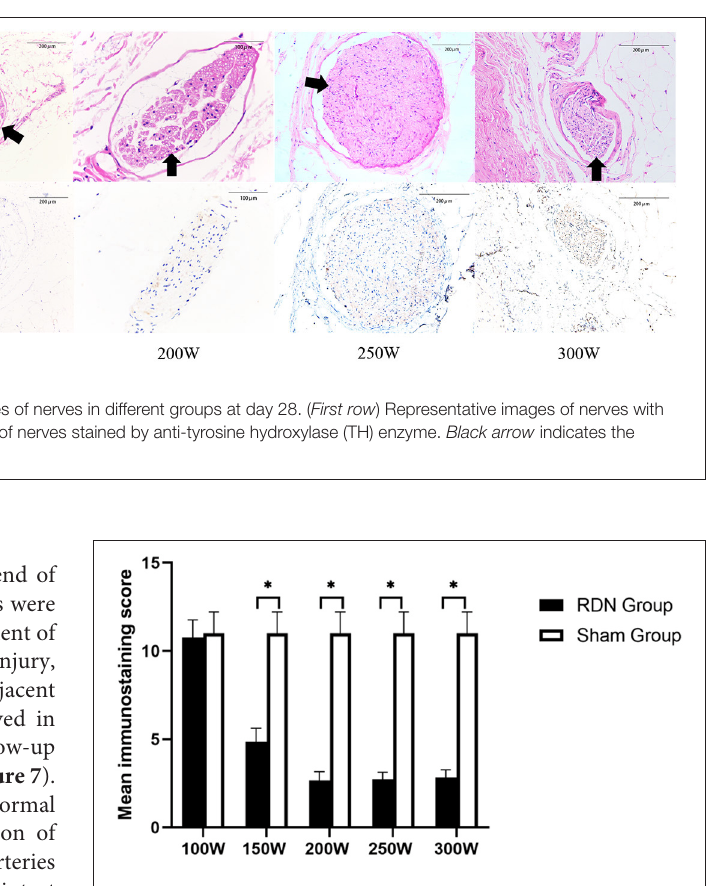
FIGURE 6 | Semiquantitative immunohistochemical evaluation of periarterial nerves at day 28. * <